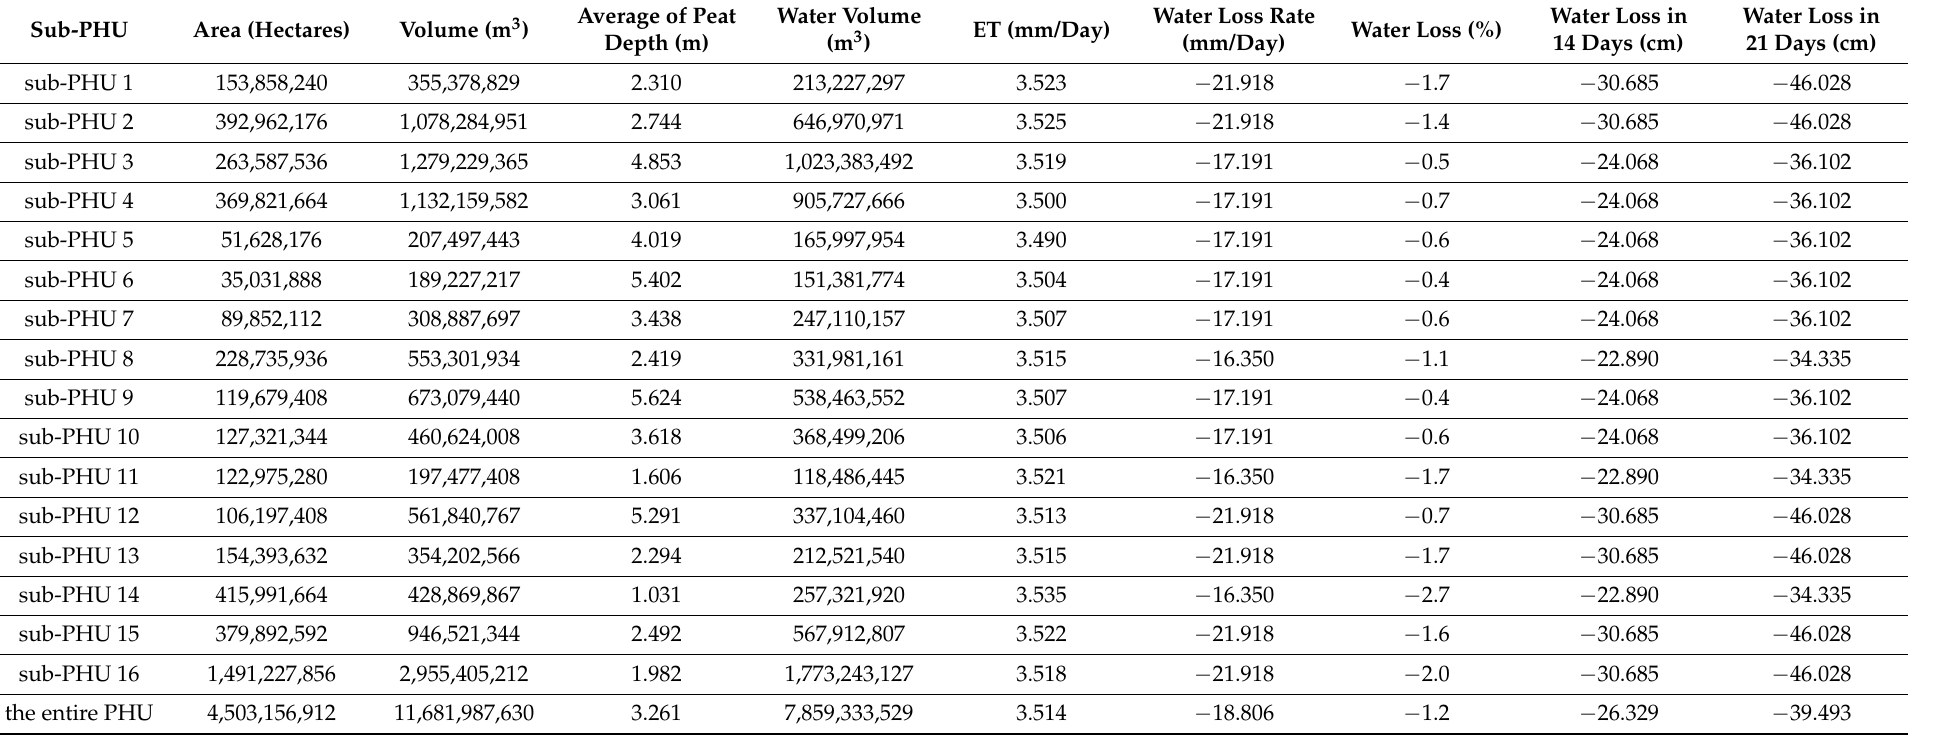
Table 7. The calculation results of the area, the volume of peat soil, the average thickness of peat, the volume of peat water, and the rate of groundwater subsidence in Kahayan–Sebangau